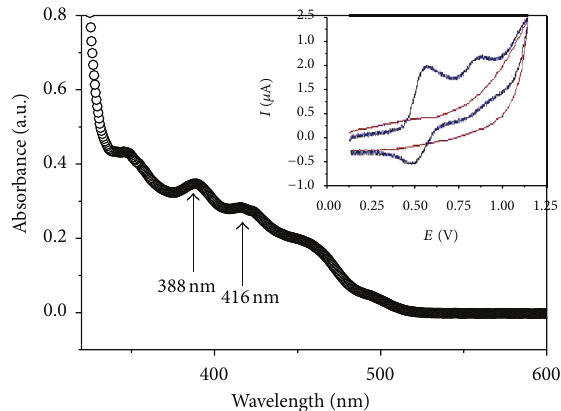
Figure 1: Absorption spectra of (tpbi) 2 Ir(acac) material. The inset was cyclic voltammetry curve of the iridium dye.